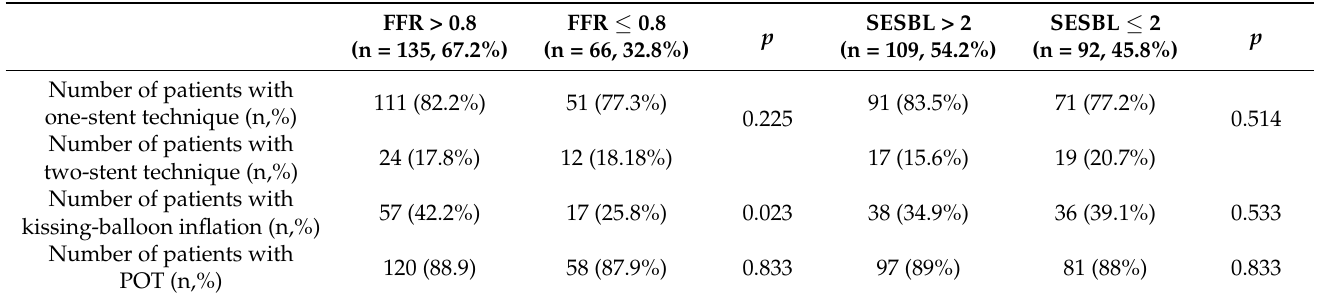
Table 3. Differences between revascularization techniques according to the parameters used to assess the success of the procedure.